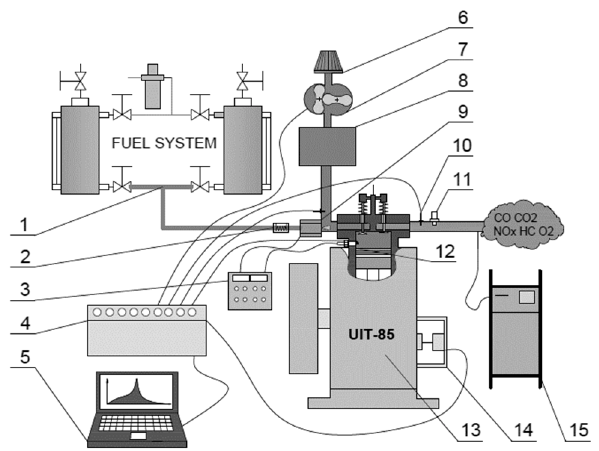
Figure 1. Test bench. 1—Refueling system; 2—Injector; 3—Electronic engine control system; 4,5—Data acquisition system with computer system; 6—Air filter; 7—Air flowmeter; 8—Surge tank of